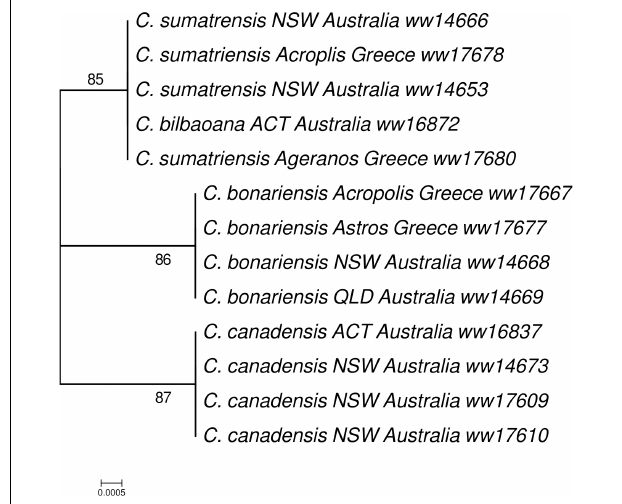
TABLE 2 | SSR (simple sequence repeats) statistics of C. bonariensis